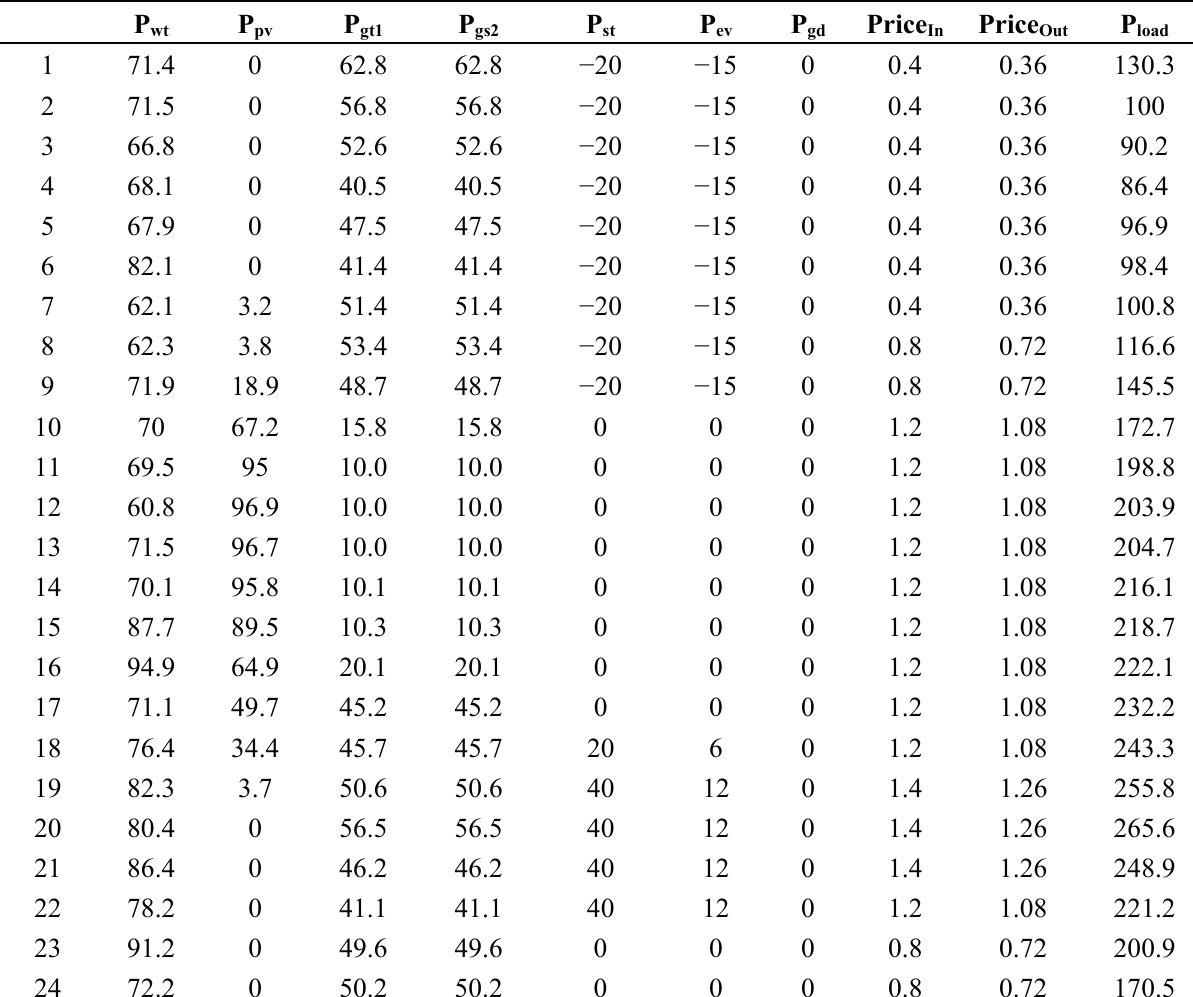
Table 2. The optimal output in Mode